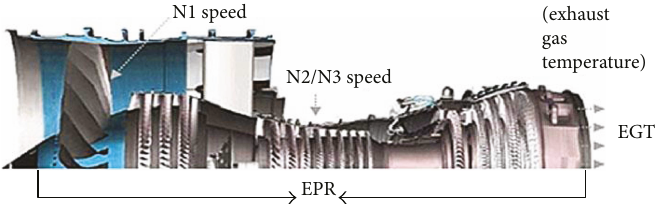
Figure 2: Main operation parameters of aircraft engines [20]. Table 1: Gas turbine engine failures and causes [28].